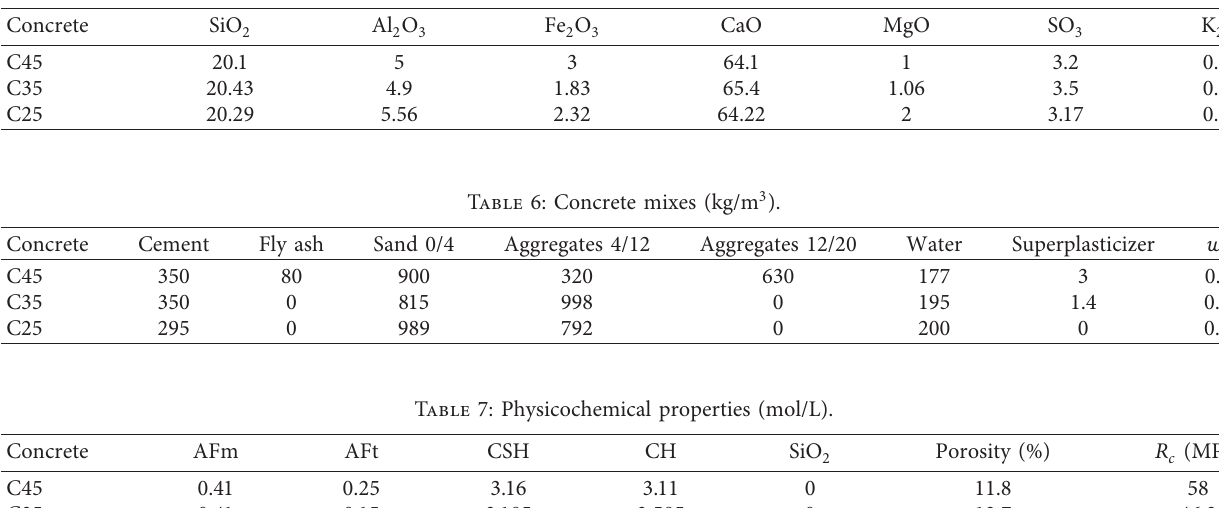
Table 5: Cement composition (%).